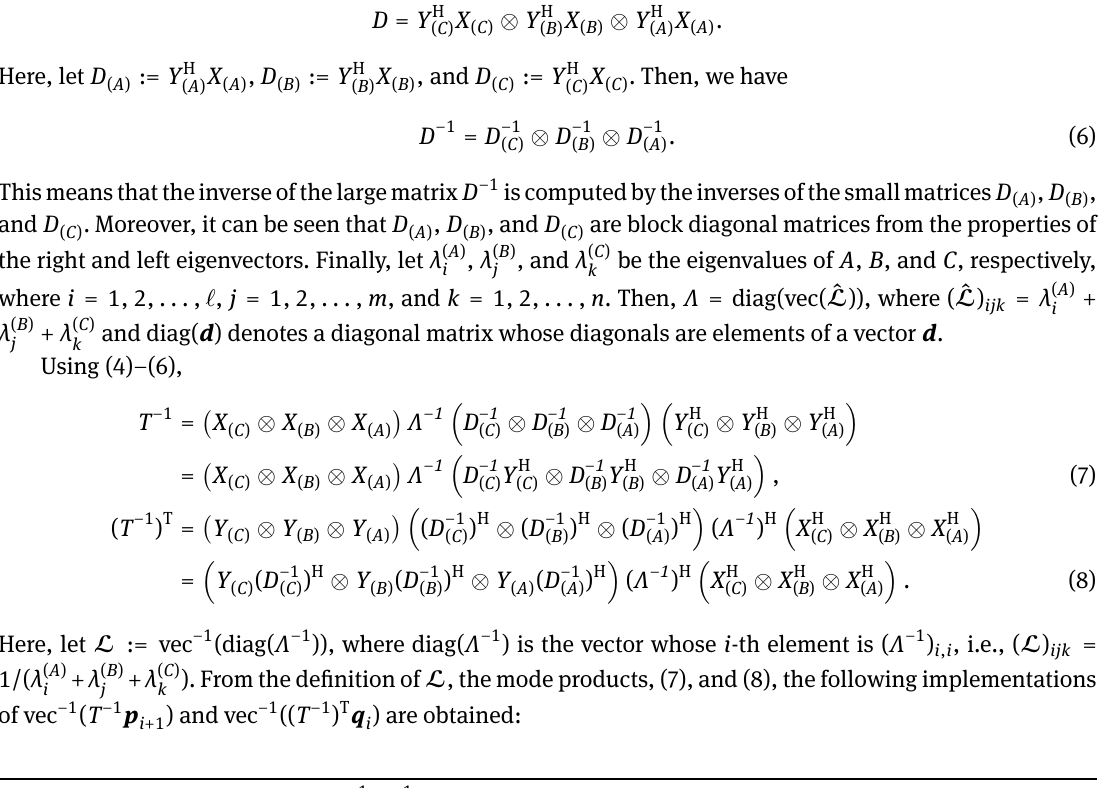
Algorithm 3-1 Computation of vec −1 ( T −1 p